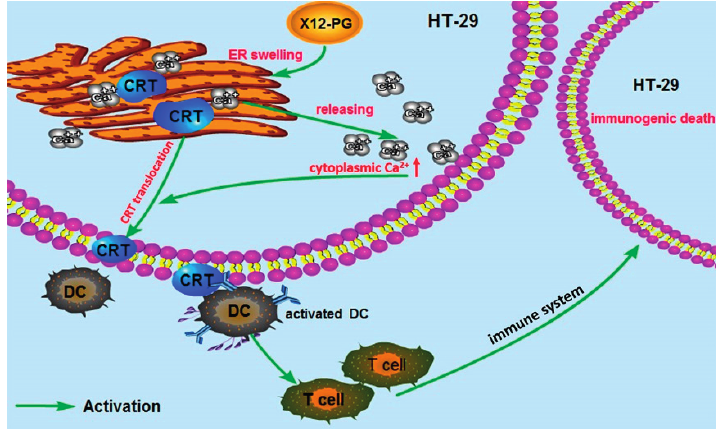
Figure 8. Properties of immunogenic cell death (ICD) induced by X12-PG in HT-29 cells. As a result of endoplasmic reticulum stress (stimulated by X12-PG), cancer cells expose CRT on their plasma membrane at a pre-apoptotic stage. This facilitates the recruitment of dendritic cells (DCs) into the tumor bed, the engulfment of tumor antigens by DCs (stimulated by CRT), and optimal antigen presentation to T cells (stimulated by